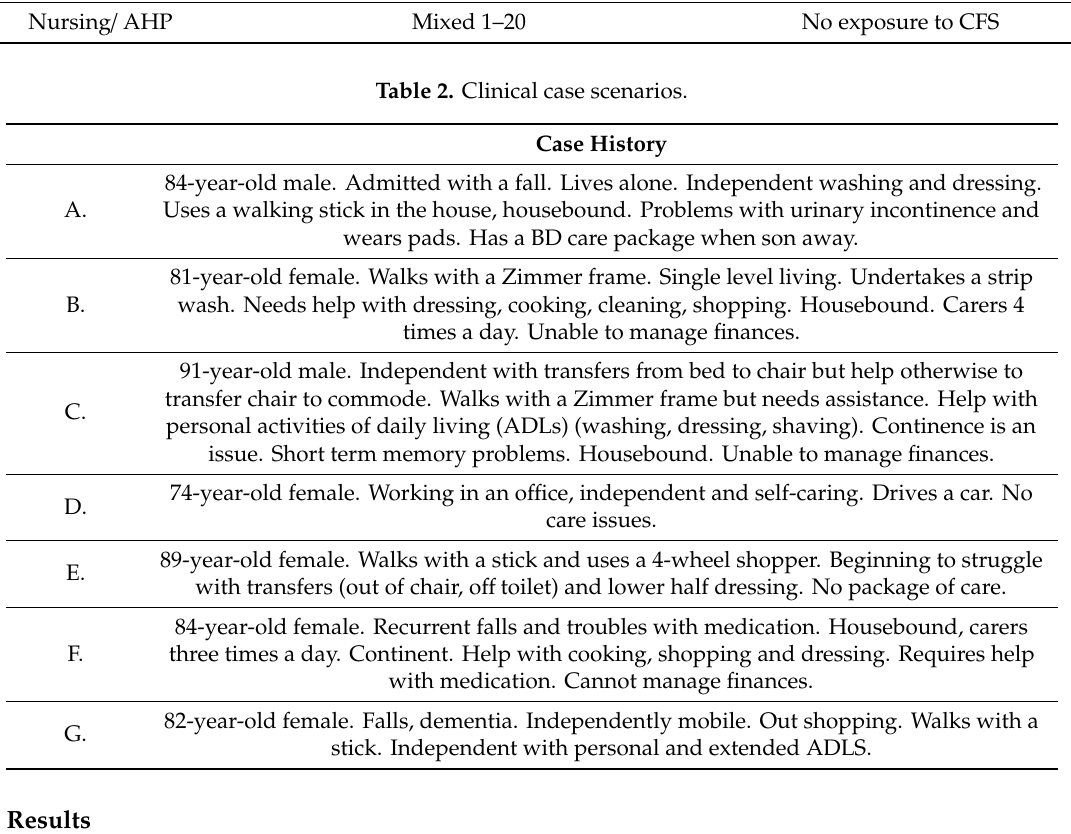
Table 2. Clinical case